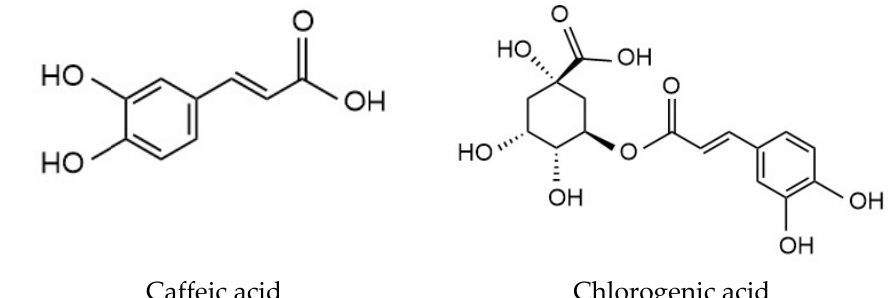
Figure 1. Structures of quinic acid, caffeic acid and chlorogenic acid.